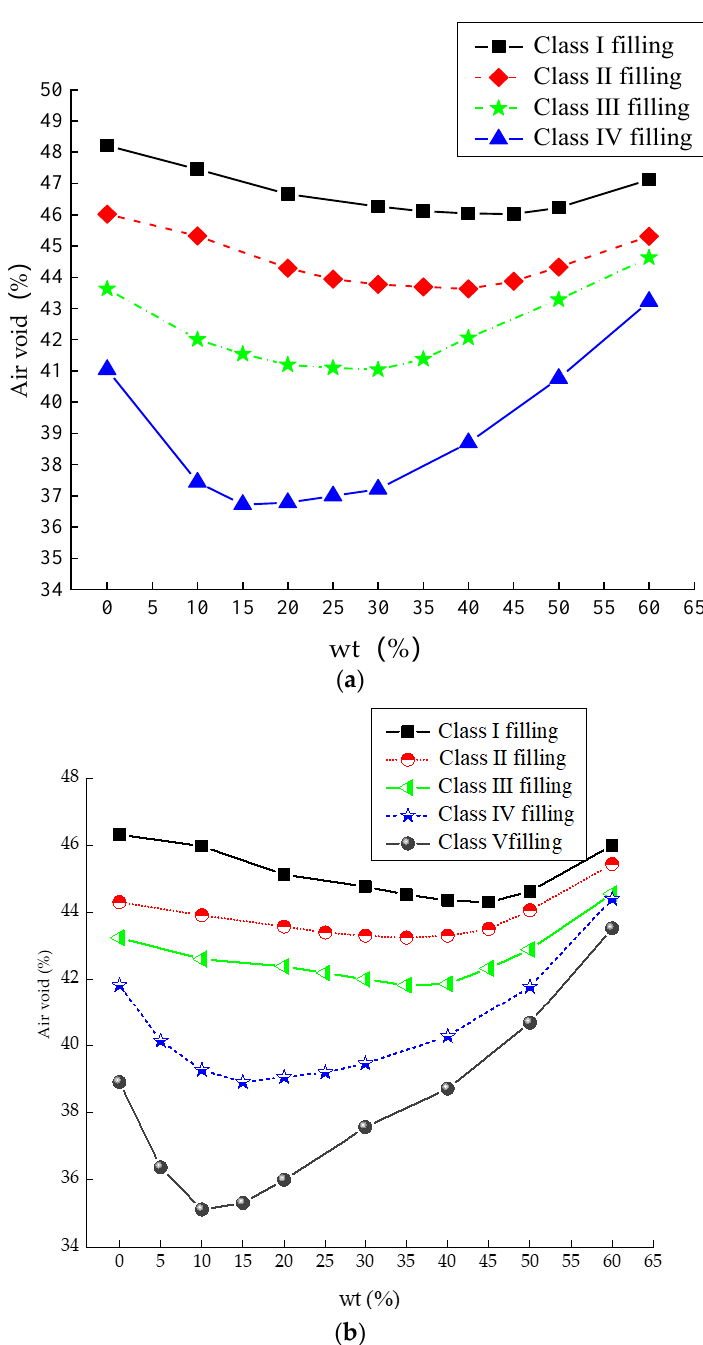
Figure 4. Air void variations with secondary particle size fractions: ( a ) gradation 1; ( b ) gradation 2. Table 8. Fine aggregate grading compositions.